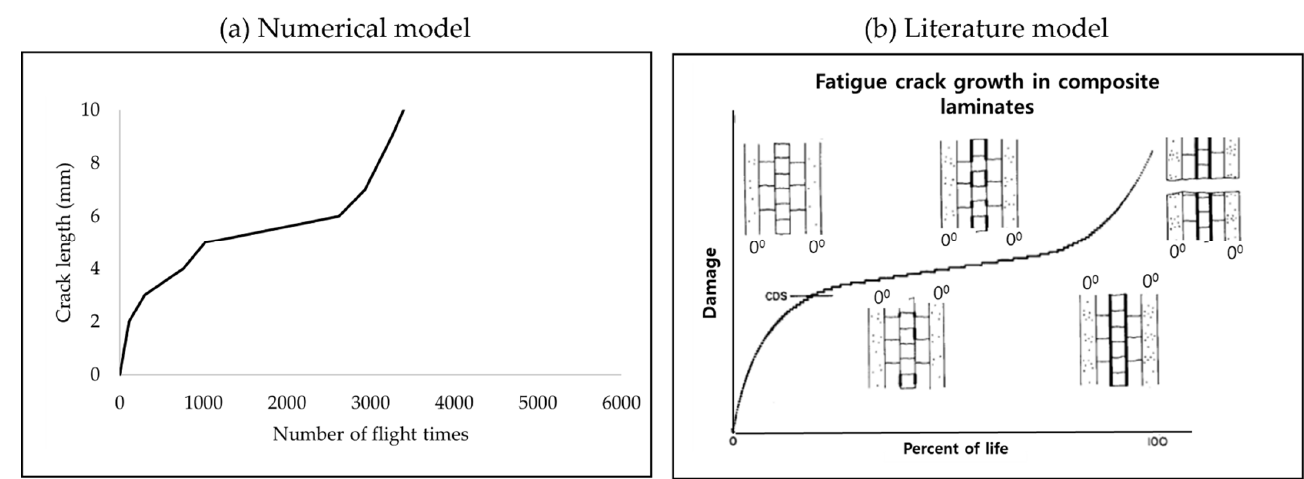
Figure 10. ( a ) Crack propagation plot of the current numerical model and ( b ) a comparison with the literature trend of the composite fatigue crack propagation curve